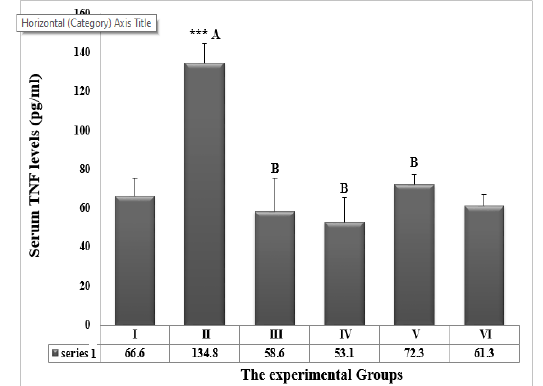
Figure.5. The effect of gugglsterone on TNFα levels in the serum of OVA-induced asthma in rats. Values are indicated as means ± Std. Error (n=8) for each group. Group I: Control group, Group II: Positive control group (with sensitization), Group III: Guggulsterone (25 mg/kg) with sensitization, Group IV: Guggulsterone (50 mg/kg) with sensitization, Group V: Prednisolone (4.12 mg/kg) with sensitization, Group VI: guggulsterone (50 mg/kg) without sensitization. *** symbol referred to significant different (p<0.001) compared to control group, unpaired test student t-test. Groups with non- identical letters are significantly different